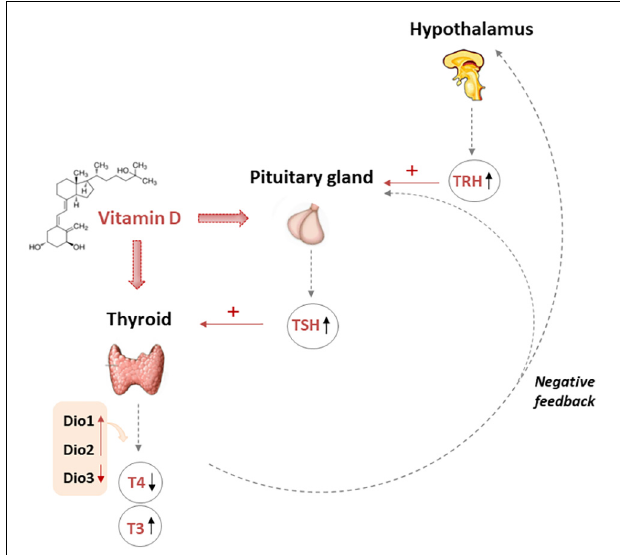
FIGURE 2 | Multiple action of vitamin D affecting TH levels. The pituitary gland secretes TSH that stimulates the thyroid to produce thyroxine (T4) and triiodothyronine (T3). Moreover T3 may be produced in peripheral organs by deiodination from circulating T4. Vitamin D fits in the complex mechanisms of regulation of THs. In fact, vitamin D could increase TRH-induced-TSH secretion by pituitary thyrotroph cells. However, it is also possible that the finding of low TSH in the presence of a high vitamin D could be due, almost in part, to increased THs caused by the stimulatory effect of vitamin D on thyrocytes, and the activation of the negative feedback control that the THs exert over the hypothalamus and pituitary gland, thus finely modulating the release of TRH, TSH, and the TH themselves. TRH Thyrotropin-releasing hormone, TSH thyroid stimulating hormone, T3 triiodothyronine, T4 thyroxine, DIO deiodinase.